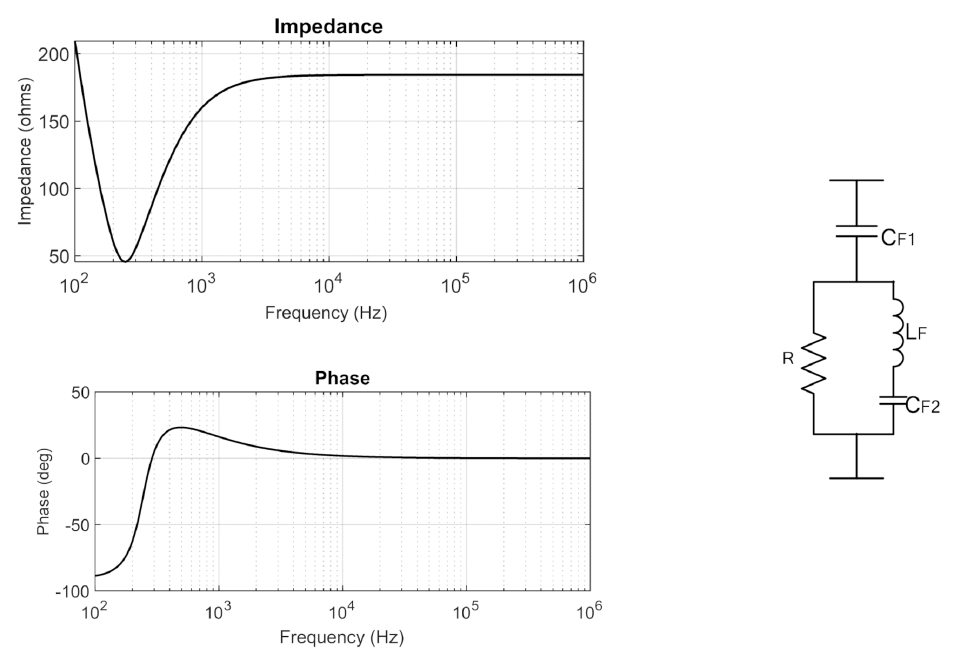
Figure 1. The C-type filter (CTF) single-phase equivalent